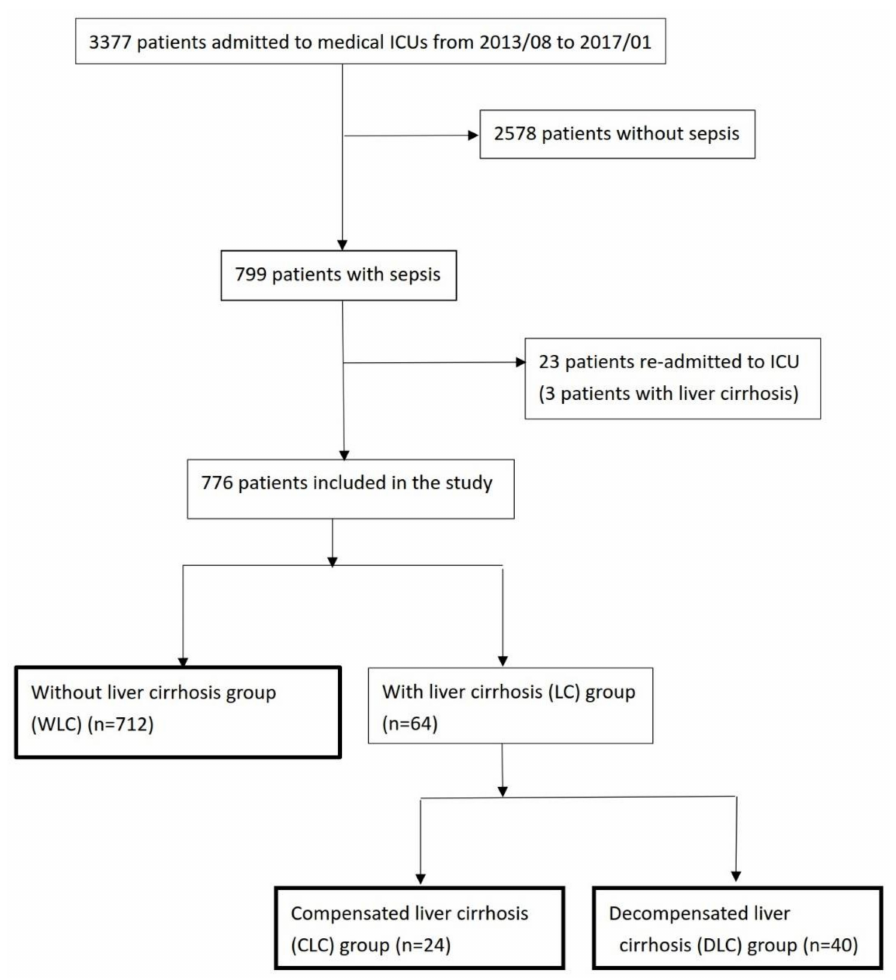
Figure 1. Among 799 patients who were diagnosed with sepsis from August 2013 to January 2017, 776 patients were included in the study. Abbreviations: WLC, without liver cirrhosis; LC, liver cirrhosis; CLC, compensated liver cirrhosis; DLC, decompensated liver cirrhosis. According to the Third International Consensus Definitions for sepsis and septic shock, sepsis is defined as a life-threatening organ dysfunction due to a disproportionate host response to infection [8,25,26]. Organ dysfunction can be represented by an increase in SOFA score of 2 points or more, which is associated with an in-hospital mortality greater than 10%. Septic shock makes up a subset of patients with sepsis. It is identified as sepsis with persistent hypotension requiring vasopressors to maintain a mean